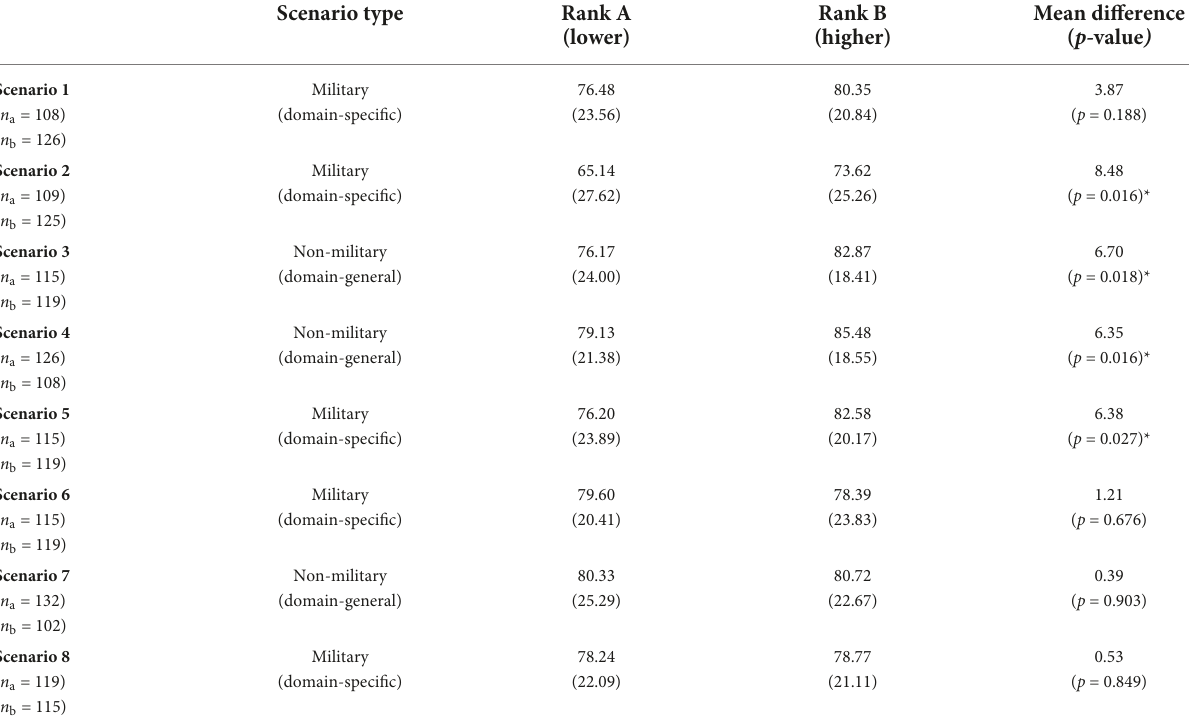
TABLE 7 Group differences for in perceived power by rank